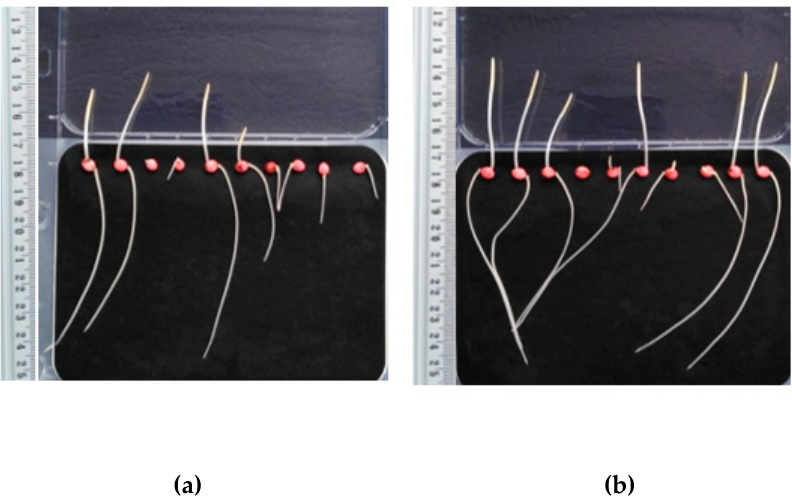
Figure 5. Sorghum saccharatum after three days of incubation: (a) Untreated sample, (b) HS fertilization.